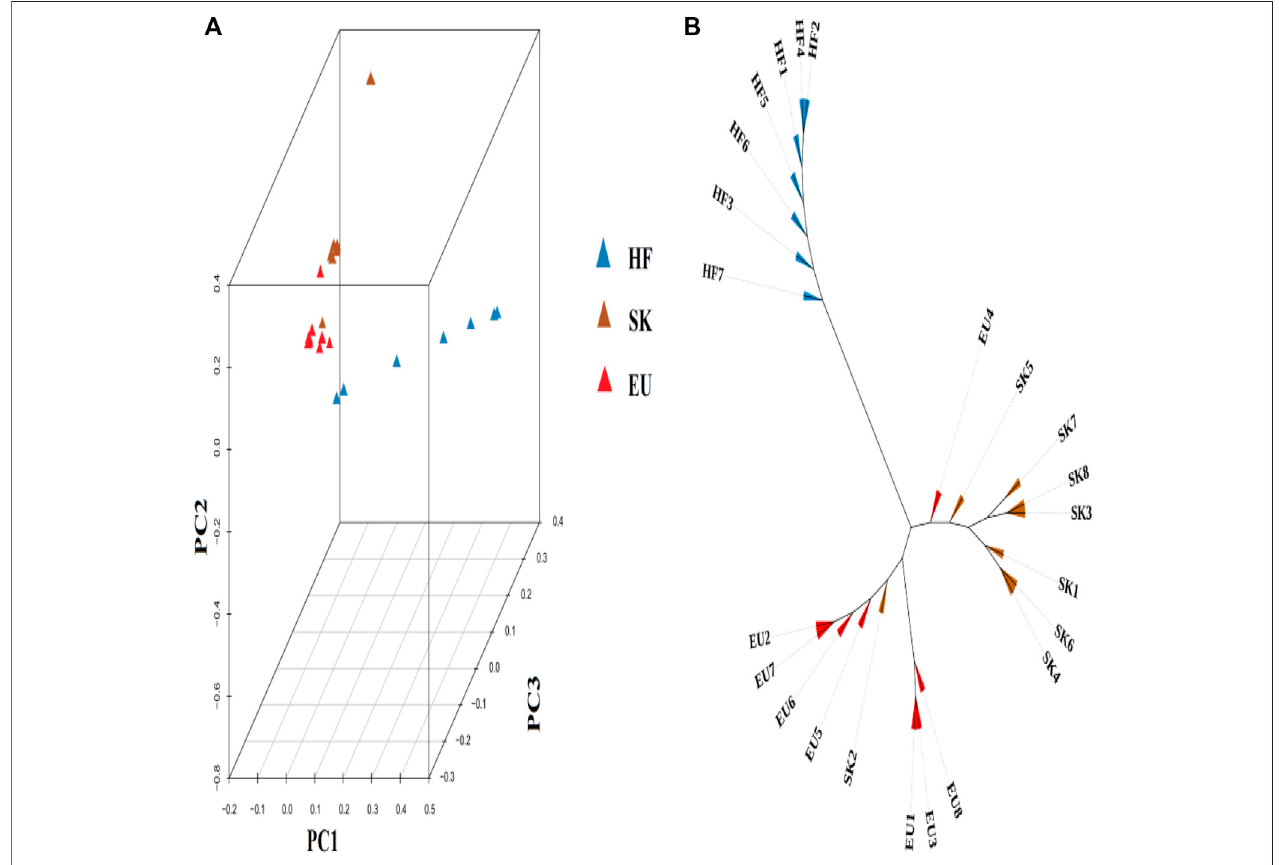
FIGURE 1 | (A) The 3D PCA plot of pigeon population. EU (Euro-pigeon), SK (Silver King), HF (High fl yers). (B) Cluster tree of three pigeon breeds.